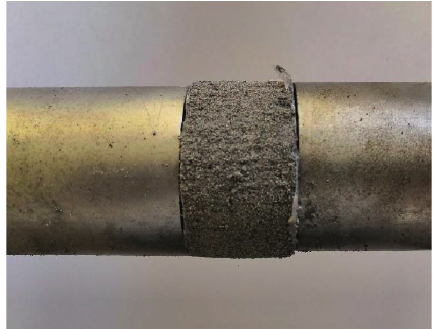
Figure 2: The SHPB test.